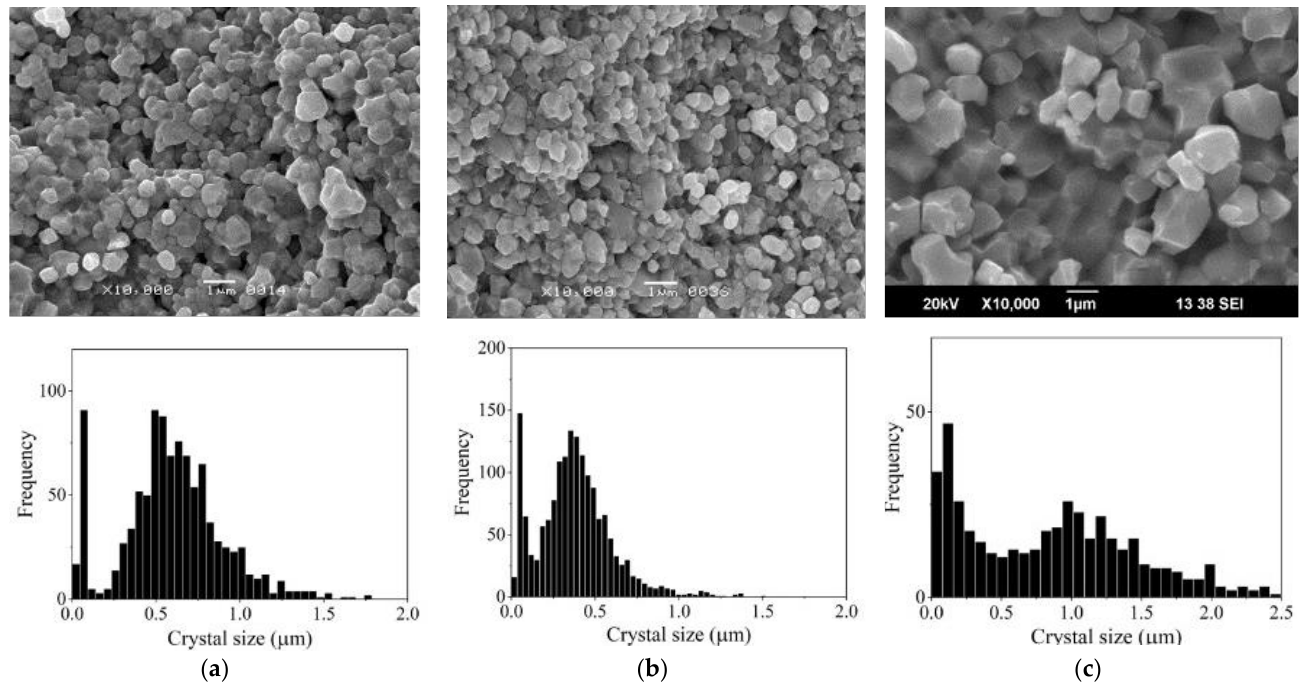
Figure 9. Microstructure and grain size distribution in CS samples of powder activated by TVT with additive 0.3% ( a ), 1% ( b ), and 3% ( c ) AmCl. 284 When comparing the histograms in Figure 3 and Figure 8, it can be seen that under 285 CS conditions, the size of the main component of crystalline grains increased, and a fine 286 component isolated in a narrow size range appeared. The result of crystal mass redistri- 287 bution is similar to the change in powder dispersion during TVT (Figure 4) with CS at 244 288